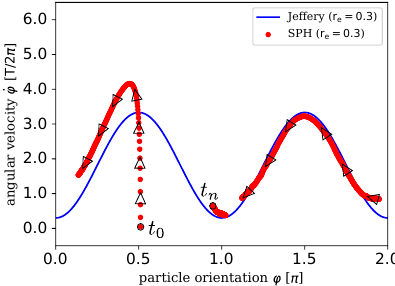
Figure 7. Normalized angular velocity ˙ ϕ over rotation angle ϕ . Comparison of SPH results (simulation c ) with analytical solution by Jeffery [9] for r e = 0.3. Black arrows additionally show the parameter of time from the start of the simulation at t 0 to the end t n